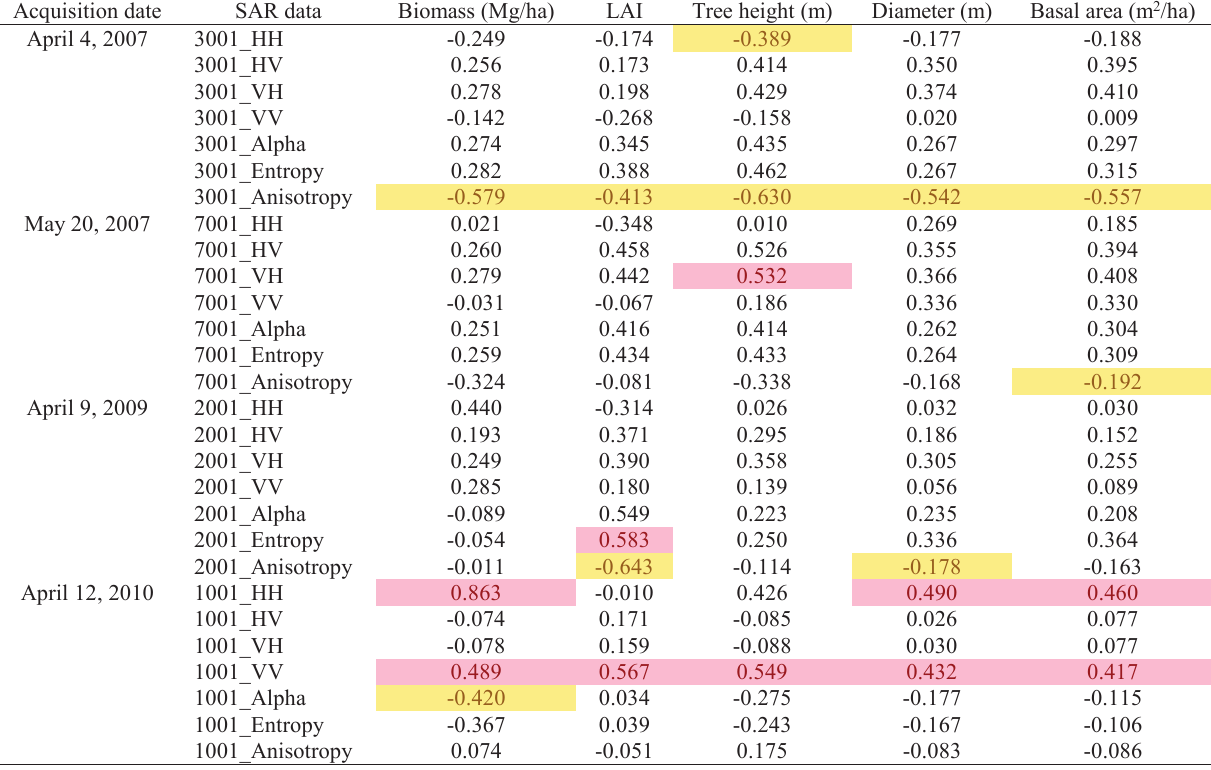
Table 2 Pearson correlation coefficients ( r) of SAR backscattering and polarimetric features with biophysical forest stand parameters. The two highest negative (orange) and positive (pink) correlations between each SAR data and forest stand properties are